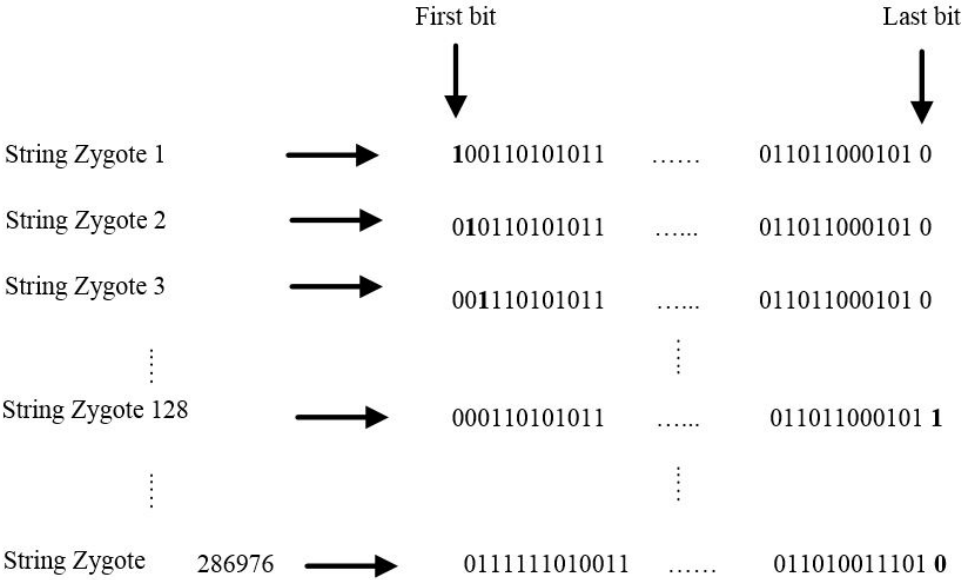
Figure 3. One-bit change example .